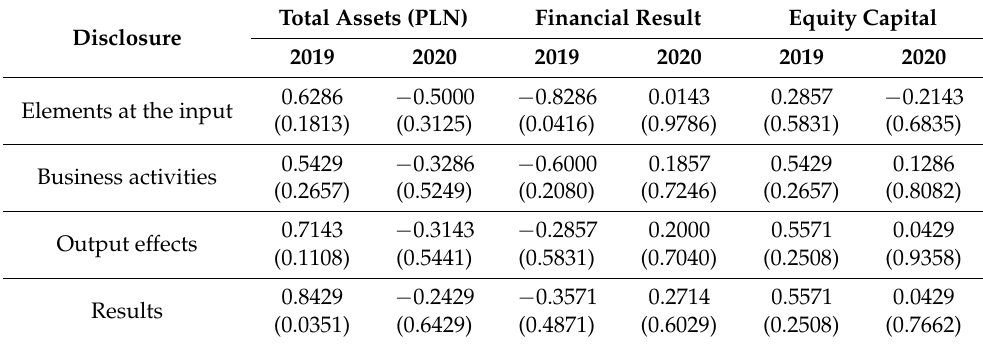
Table 10. Spearman’s rank correlations calculated for financial